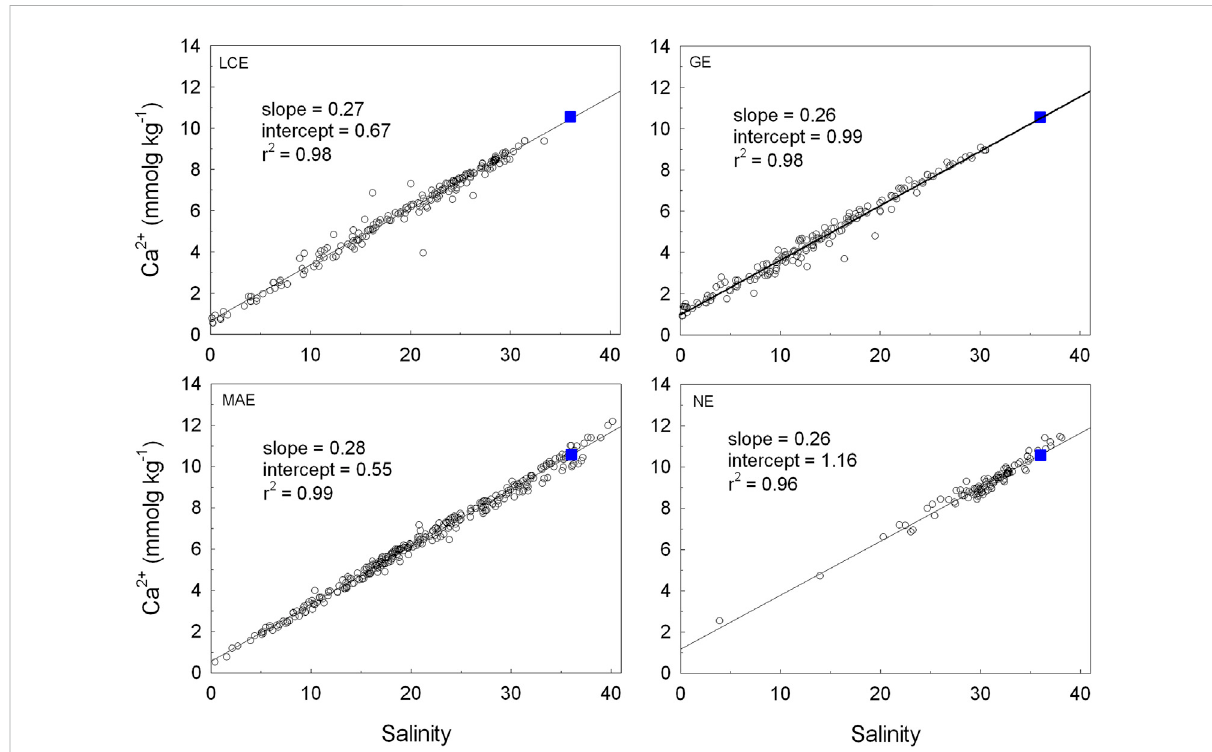
FIGURE 6 Linear regression between estuarine [Ca 2+ ] and salinity in the four studied nwGOM estuaries between 2014 and 2018. The blue square in each panel represents seawater condition (10.57 mmol kg − 1 at salinity